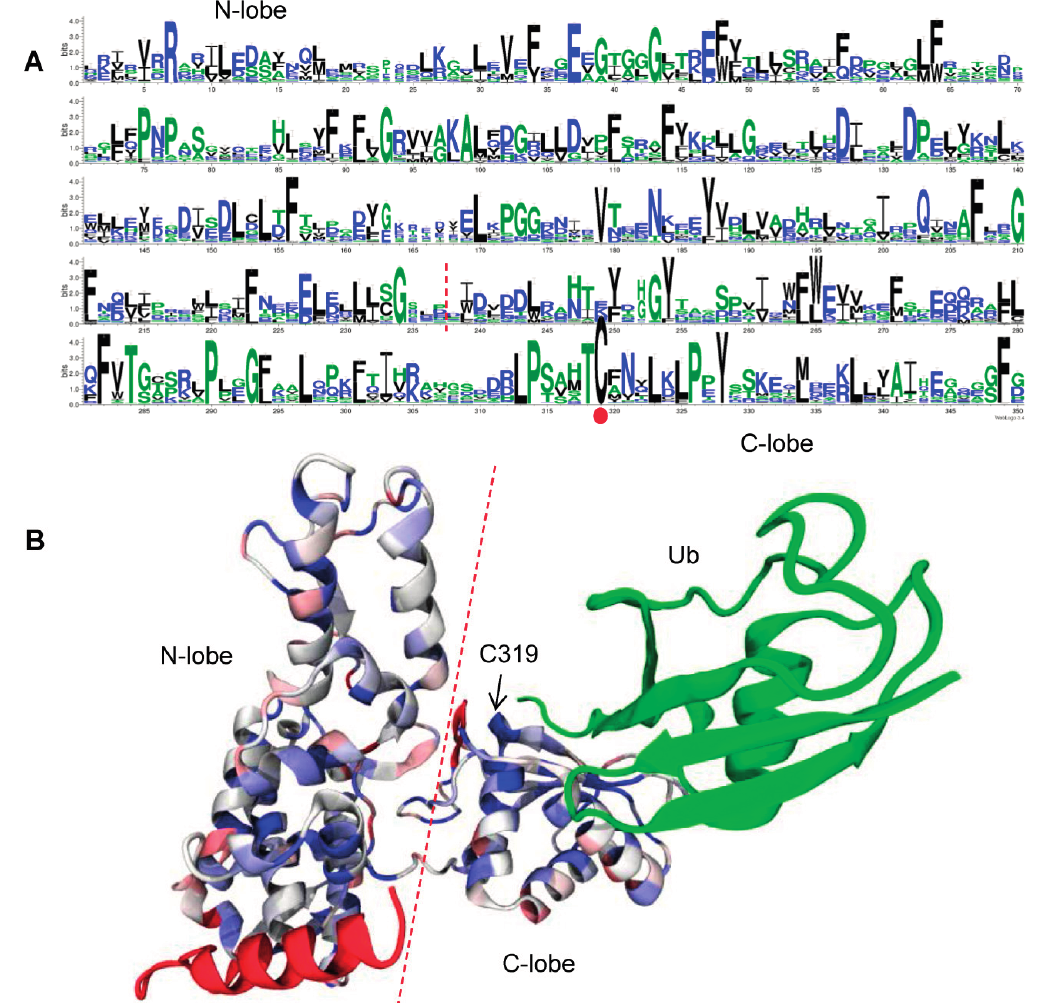
Figure 6. Logo and 3D representations of the highly conserved residues of 365 HECT domains in plants. Bits in the y -axis ( A and Figure S3) represent the amount of informational content at each sequence position; Note that in the 3D representations ( B ), green represents ubiquitin (Ub), and the similarity values are mapped to a color gradient from low (red) to high rate of conservation